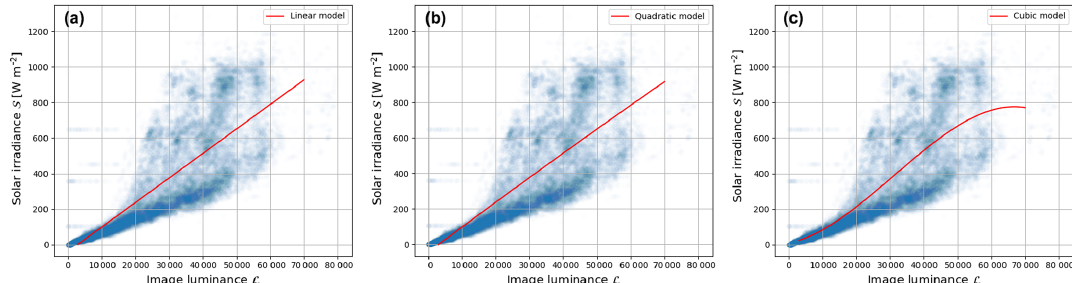
Figure 7. Empirical fit between solar irradiance and image luminance computed with our proposed framework using (a) a linear model, (b) a quadratic model, and (c) a cubic model. We observe that it deviates from linearity at higher luminance values. Higher-order polynomials are ill-conditioned.